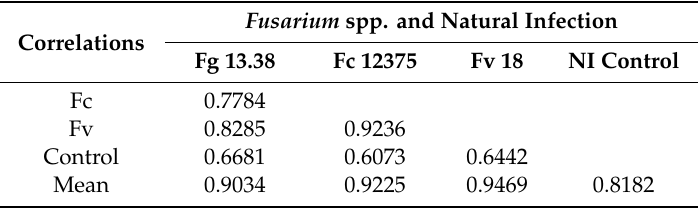
Table 6. Silk channel resistance in maize, correlations between Fusarium spp. and natural infection from Table 5,